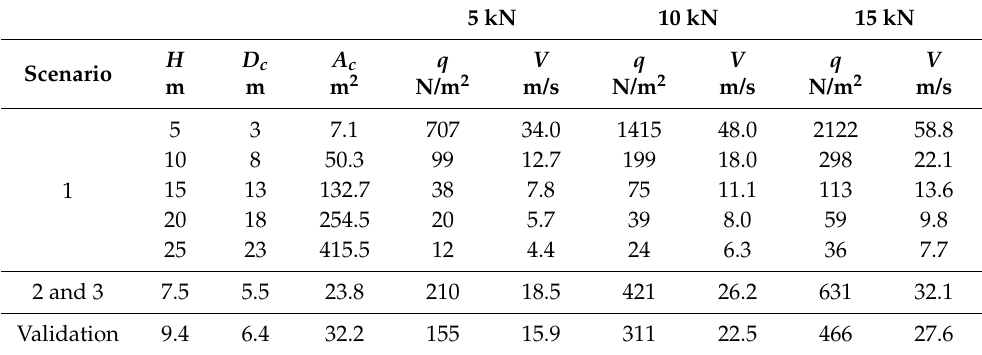
Scenario 1: slenderness 22; taper 0.030; and total tree height ranging between 5 m, 10 m, 15 m, 20 m, and 25 m. Scenario 2: tree height 7.5 m; taper 0.030; and slenderness ranging between 8, 16, 24, 32, and 40. Scenario 3: tree height 7.5 m; slenderness 22; and taper ranging between 0.010, 0.020, 0.030, and 0.050. Initial crown height fixed at 2.0 m (crown heights = H −